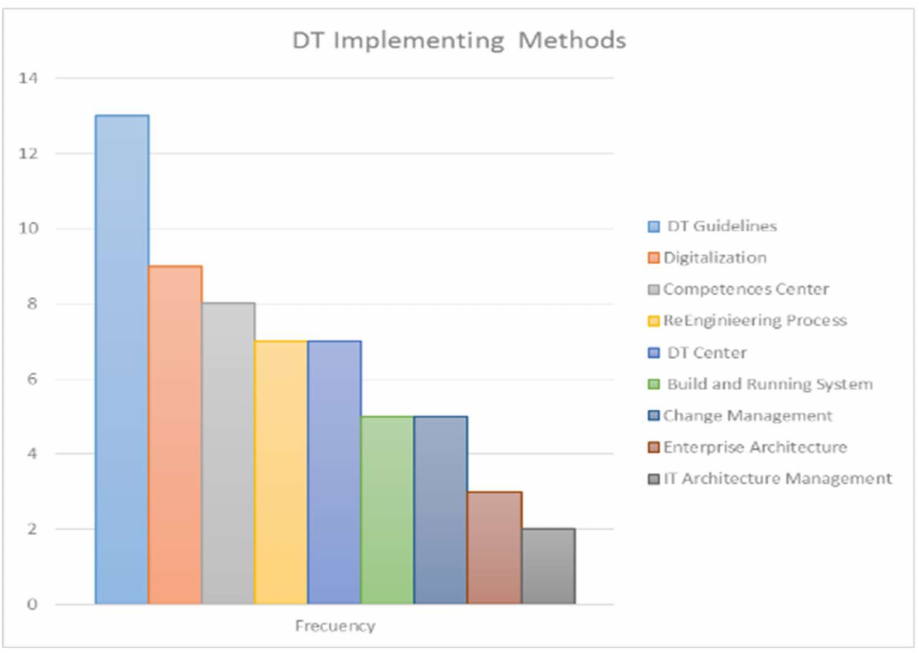
Figure 10. Implementing methods of DT at a